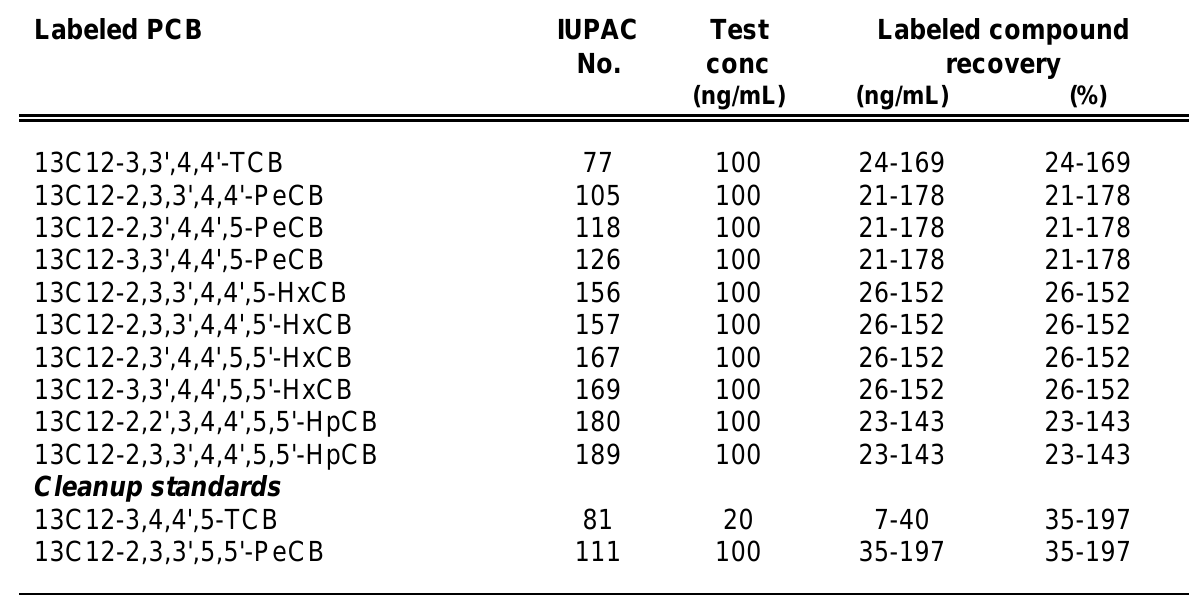
Table 7. Labeled Compound Recovery in Samples When All PCBs are Tested Labeled PCB